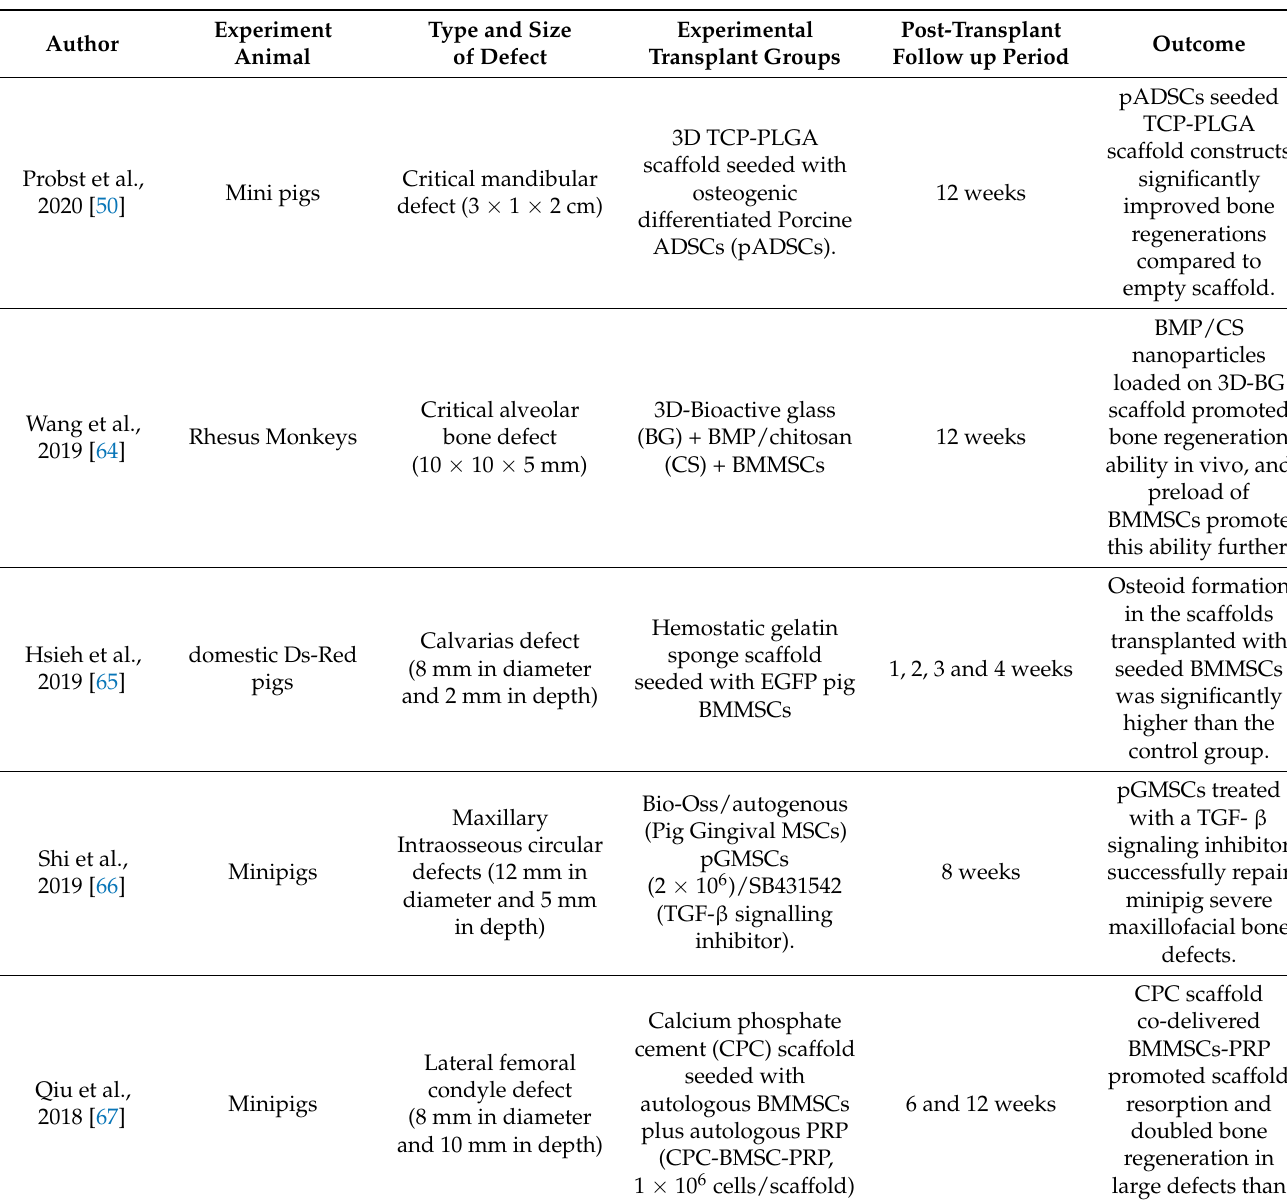
Table 1. Pre-clinical experiments of MSCs-combined with biomaterial for bone regeneration in large animal bone defect